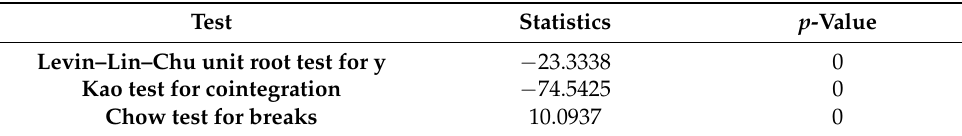
Table 4. Robustness